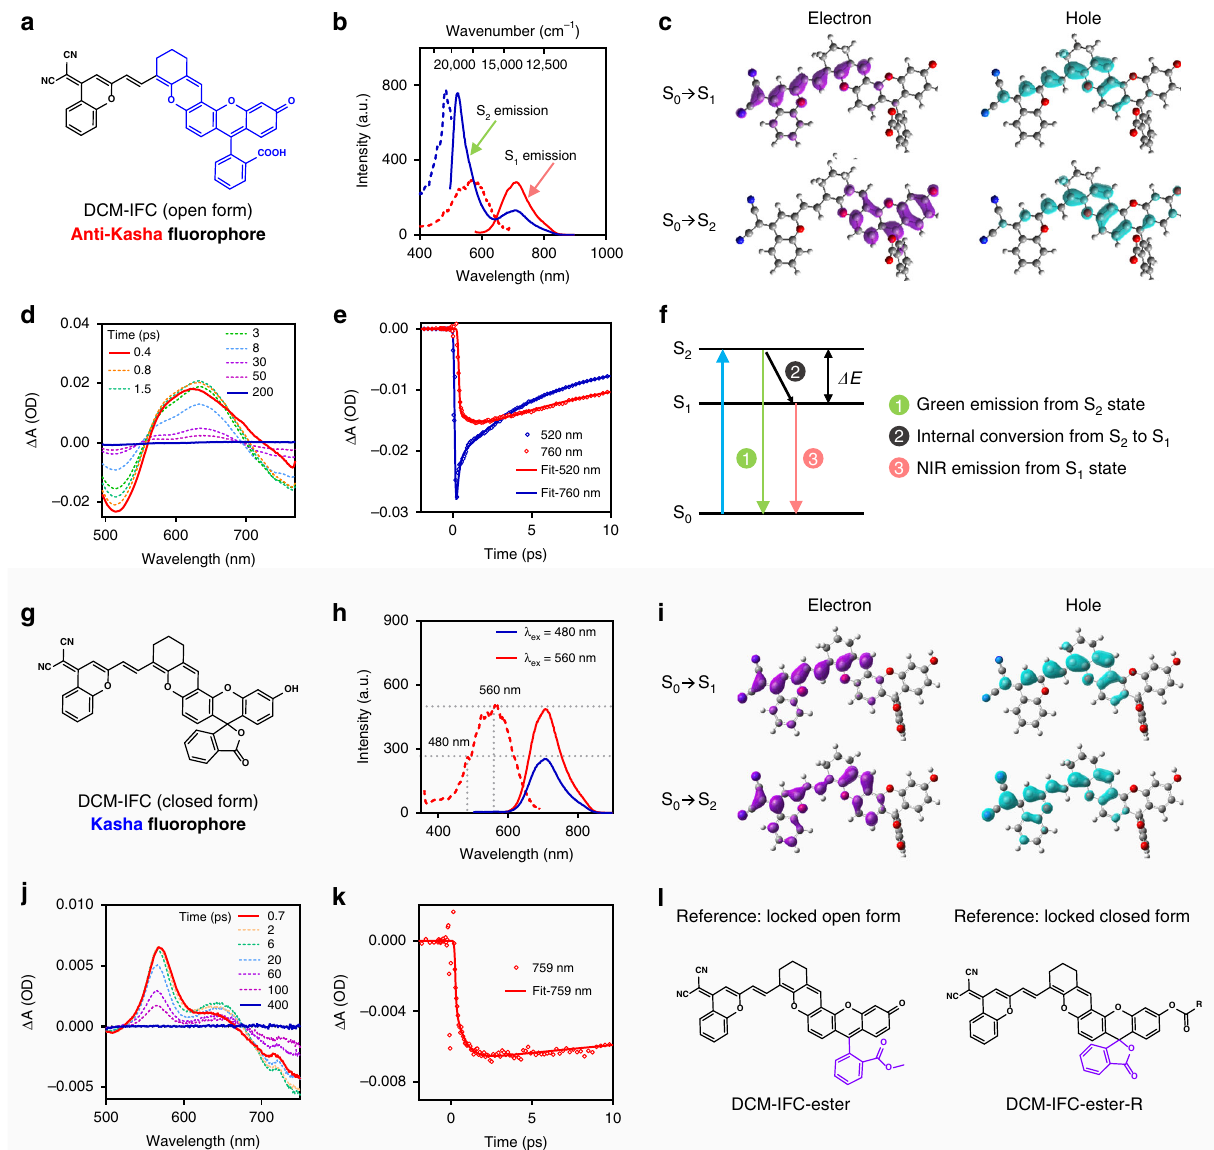
Fig. 2 Characterization of anti-Kasha mechanism in open-form versus Kasha mechanism in closed-form. a Chemical structure of DCM-IFC in its open form. b Excitation spectra (dotted line, monitored at λ em = 520 and 710 nm) and emission spectra (solid line, excited at λ ex = 480 and 560 nm) of open- form DCM-IFC. c Electron – hole analysis involved during the photoexcitation of the open form, based on the molecular structure at the Franck – Condon state. Femtosecond time-resolved transient absorption spectra ( d ) and kinetics ( e ) of open-form DCM-IFC (excited at λ ex = 480 nm). f Jablonski diagram illustrating the anti-Kasha mechanism. g Chemical structure of DCM-IFC in its closed form. h Excitation spectra (dotted line, monitored at λ em = 710 nm) and emission spectra (solid line, excited at λ ex = 480 and 560 nm) of closed-form DCM-IFC. i Electron – hole analysis involved during the photoexcitation of the closed form, based on the molecular structure at the Franck – Condon state. Femtosecond time-resolved transient absorption spectra ( j ) and kinetics ( k ) of closed-form DCM-IFC (excited at λ ex = 480 nm). Note: open-form DCM-IFC was investigated at pH 11.3 and closed-form DCM-IFC was investigated at pH 2.0. l Two structurally related reference compounds that are locked into open form or closed form. Note: all fl uorescence spectra were measured in a mixture solution of acetonitrile (MeCN)/Britton – Robinson environment would induce a spirocyclization reaction that causes the IFC moiety to adopt its closed form. Conversely, increasing pH values would promote deprotonation and change the IFC moiety into its open form. The solvent pH was increased from 2.2 to 8.0 and the spirolactone ring-opening was monitored (from Kasha to anti-Kasha): The S 2 emission at 520 nm progressively intensi fi es from an initial zero background. Here the S 2 emission response clearly established that rational modulation of emission from higher excited states can be achieved by tuning anti-Kasha/ Kasha properties.